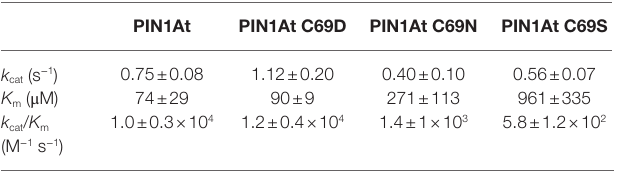
Steady-state kinetic parameters were calculated from activity measurements shown in Supplementary Figure S3 by fitting them to nonlinear regression using the Michaelis– Menten